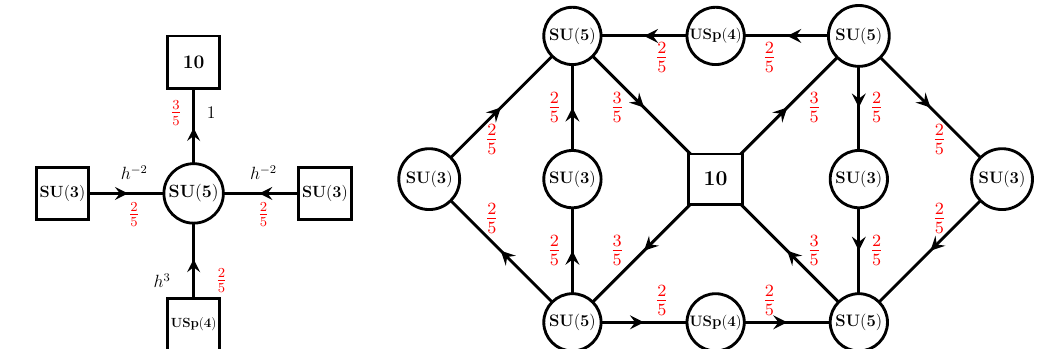
Figure 23: On the left we have the three punctured sphere, two maximal SU ( 3 ) ) minimal punctures and one maximal USp ( 4 ) puncture, with zero flux of the ( D , D 5 5 conformal matter theory. The theory has baryonic superpotentials consistent with the assigned charges. The superpotential is built by taking a triplet of fundamen- tals transforming under one of the SU ( 3 ) s, computing third antisymmetric power to build a singlet of the SU ( 3 ) , and then taking the fields transforming under USp ( 4 ) to the second antisymmetric power to build a singlet under it. This superpotential is irrelevant for the trinion. On the right hand side we glue four trinions into a genus three surface. This theory has the baryonic superpotentials as well as the ones cor- responding to closed loops in the quiver which are consistent with the charges. The ⊂ SO ( 20 ) where SO ( 20 ) is the symmetry symmetry of the theory is SU ( 10 ) × U ( 1 ) h of the 6d